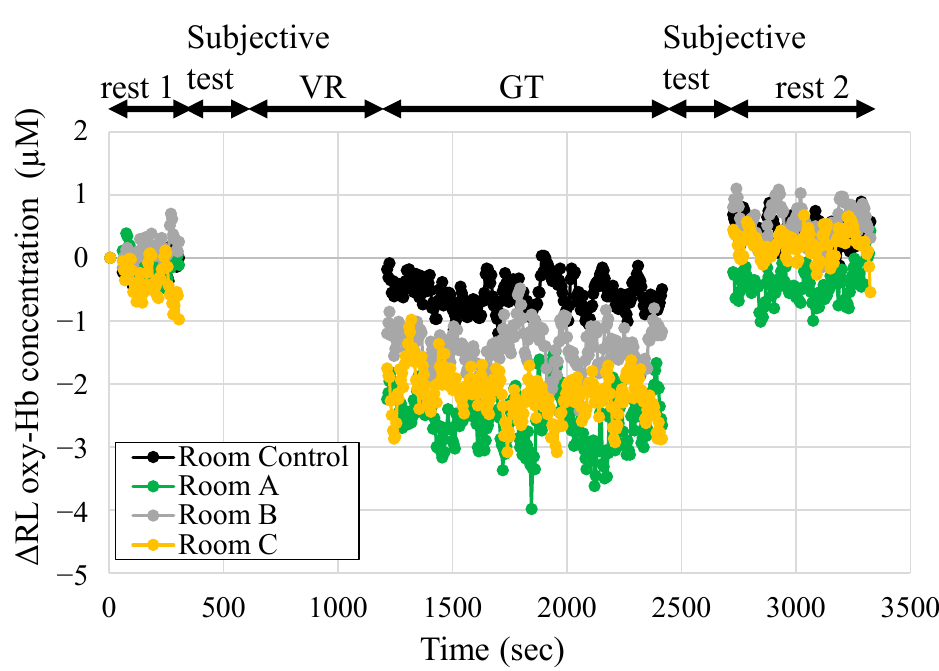
Figure 7. Change in the right-left difference in oxygenated hemoglobin ( ∆ RL oxy-Hb) in the prefrontal cortex during the experiment (rest 1, GT, rest 2), every 5 s. The vertical axis shows the difference value from 0 to 1-min means of rest 1. Data are expressed as means ( n = 7). VR, visual reality; GT, test space; Room Control, space without natural green features; Room A/B/C, space with natural green features.